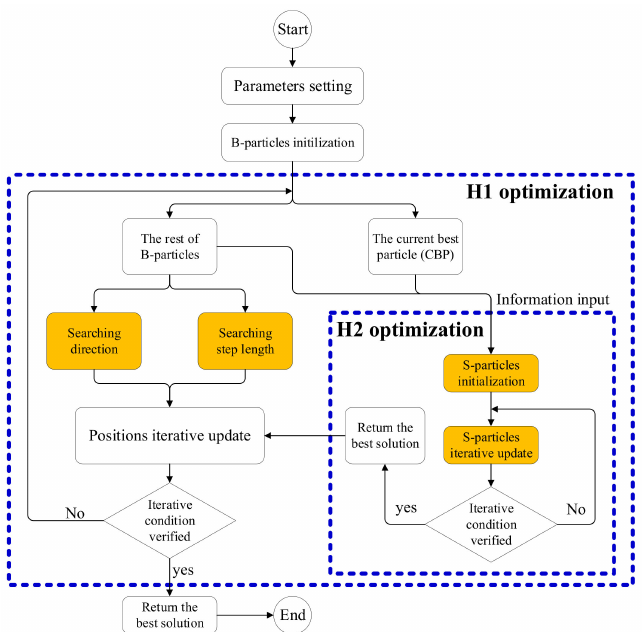
Figure 1. Flowchart of HOF.